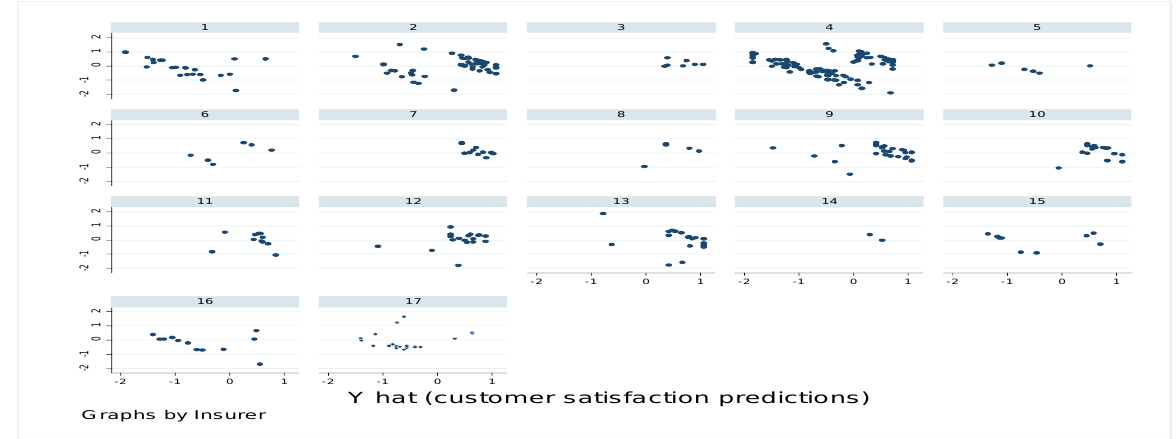
Figure 8: Scatter plot line-up by insurer of residuals against predicted values for level-1 residuals; Assurance Customer satisfaction model A model of homogeneity of level-2 residuals was assessed for the multiple level-2 residuals in the random effects due to the random covariates and due to the random intercepts. The level 2 residuals which were BLUPs of random intercept predictions when fitted against the predicted values of customer satisfaction also exhibited heteroscedasticity with an increasing pattern of higher predictions (Figure 9). Level-2 residuals from the BLUPs of random covariate (assurance) predictions against the predicted values of customer satisfaction were randomly distributed about zero with no increasing or decreasing patterns to imply homogeneity of